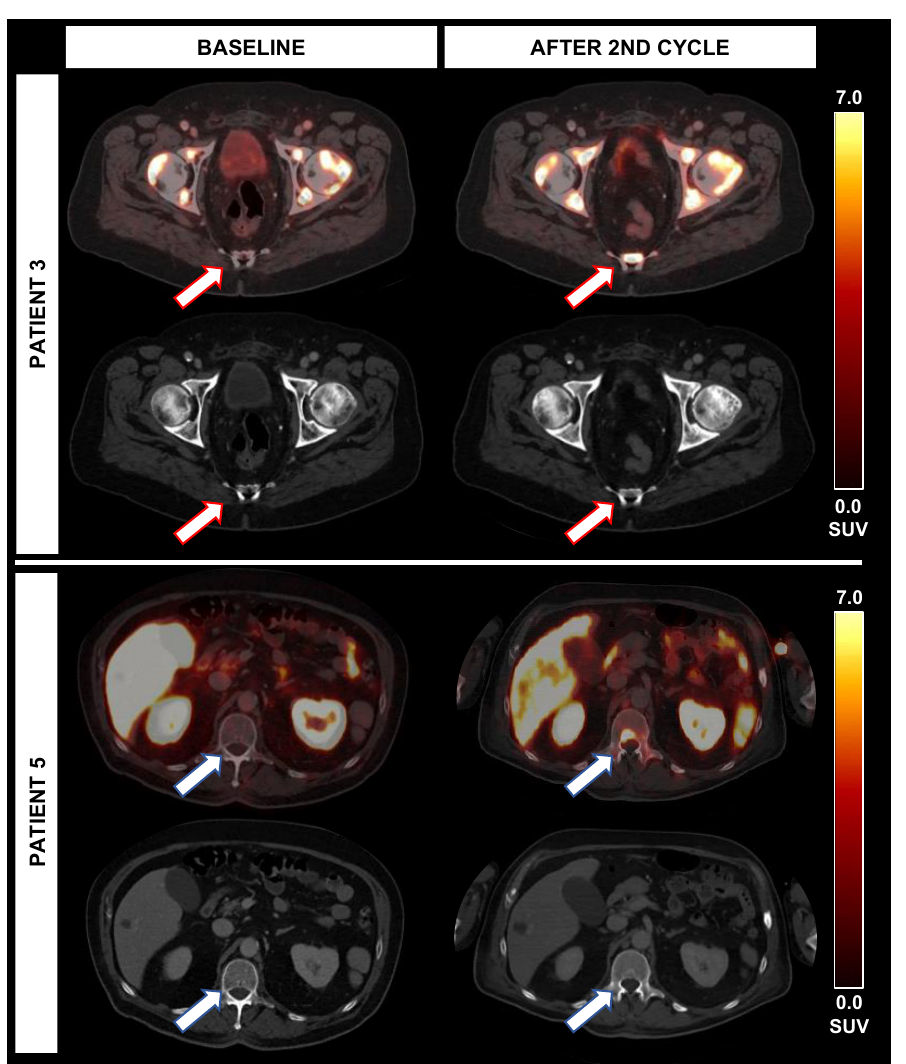
Figure 3. Occurrence of new PSMA-avid lesions during alpha therapy. While patient 3 experienced new PSMA-avid lesions (red arrows) without correlate on CT, the TTV (+3%) was stable and PSA ( − 33%) was decreasing after 2 cycles. In patient 5, new bone lesions (blue arrow) and lymph nodes with PSMA-expression were noted after the second cycle; however, both TTV ( − 65%) and PSA ( − 25%) were decreasing despite new lesions.